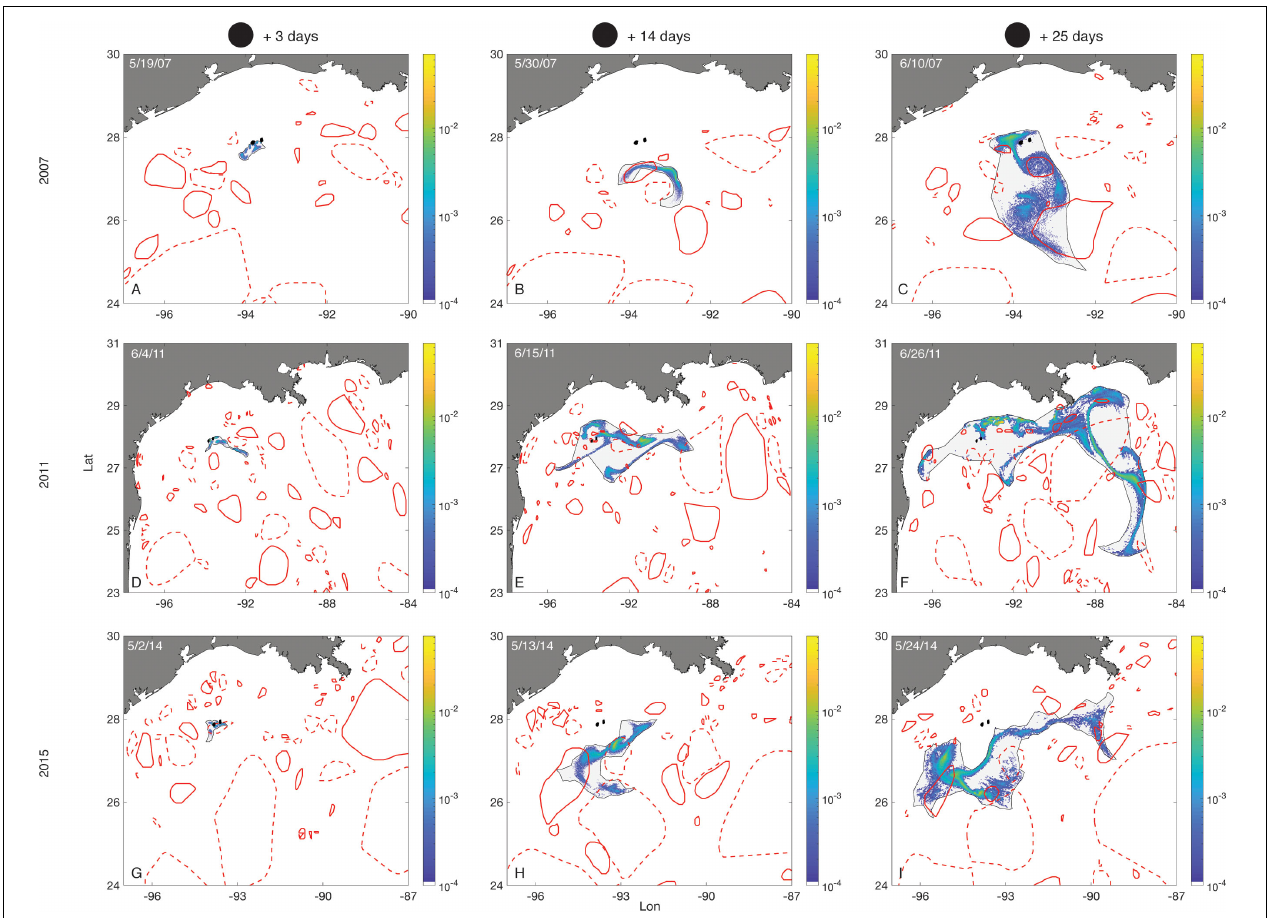
FIGURE 7 | Larval distributions– Porites astreoides . Plots show larval distributions as probability density surfaces bounded by non-convex hulls following seven days of planulation in each of three different months (rows) (larvae released from 3 days before to 3 days after the new moon of that month). The first column shows the distribution of larvae on the third day after the new moon. The next two columns show larval distributions 14 and 25 days after the new moon, respectively. Density is scaled to the maximum single cell value within a planulation event. The FGB sanctuary boundaries are shown as black filled polygons. Eddies are represented by red empty polygons. Solid lines are cyclonic eddies and dashed lines are anticyclonic